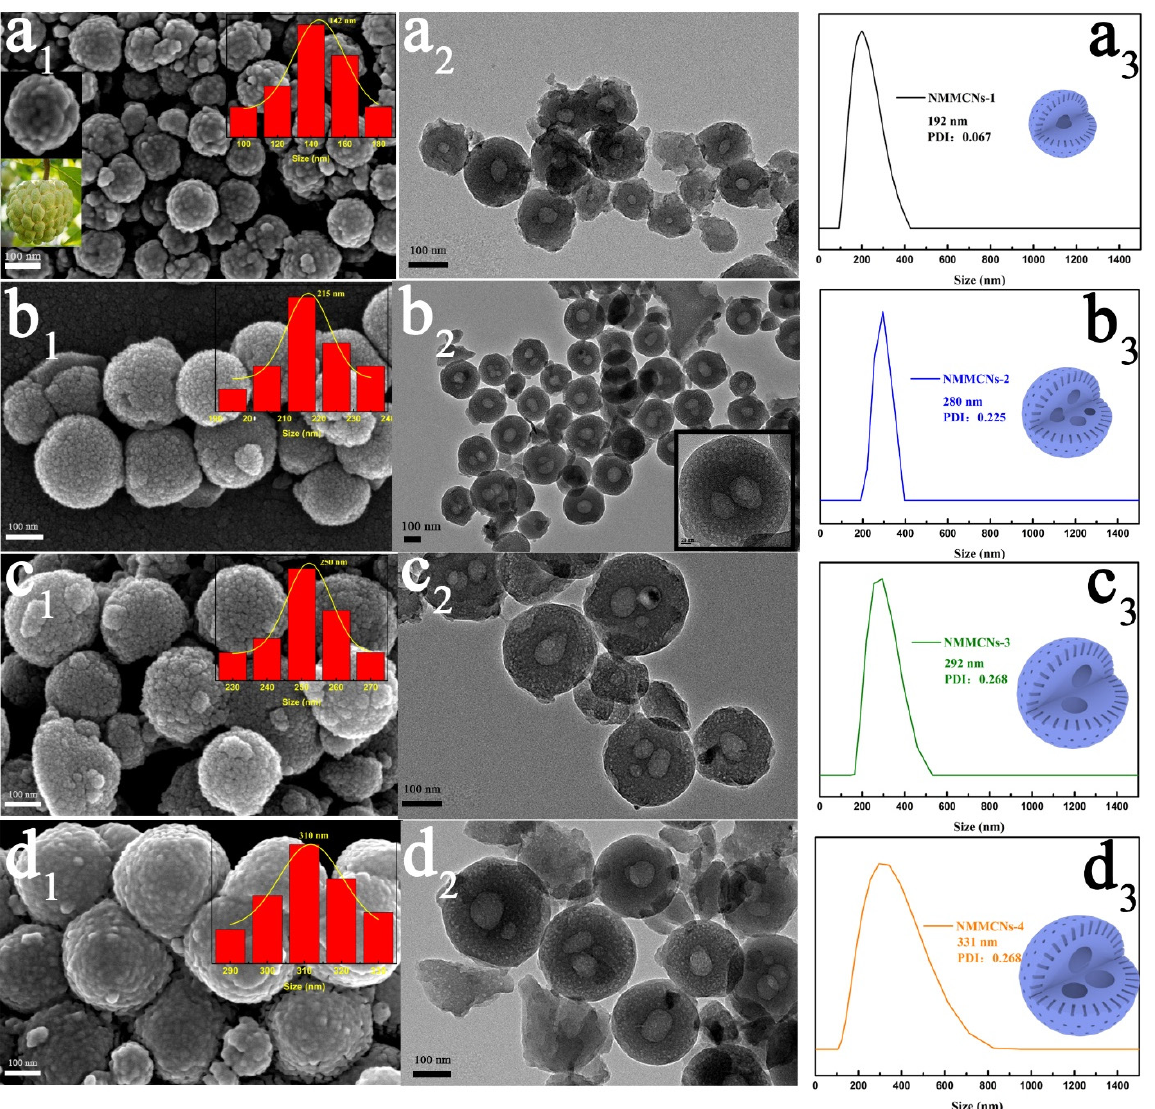
Figure 1. The SEM images ( a 1 – d 1 ), TEM images ( a 2 – d 2 ) and particle size distributions derived from DLS ( a 3 – d 3 ) of NMMCNs synthesized with different DEP contents. (Row ( a ), NMMCNs-1; Row ( b ), NMMCNs-2; Row ( c ), NMMCNs-3; Row ( d ), NMMCNs-4).